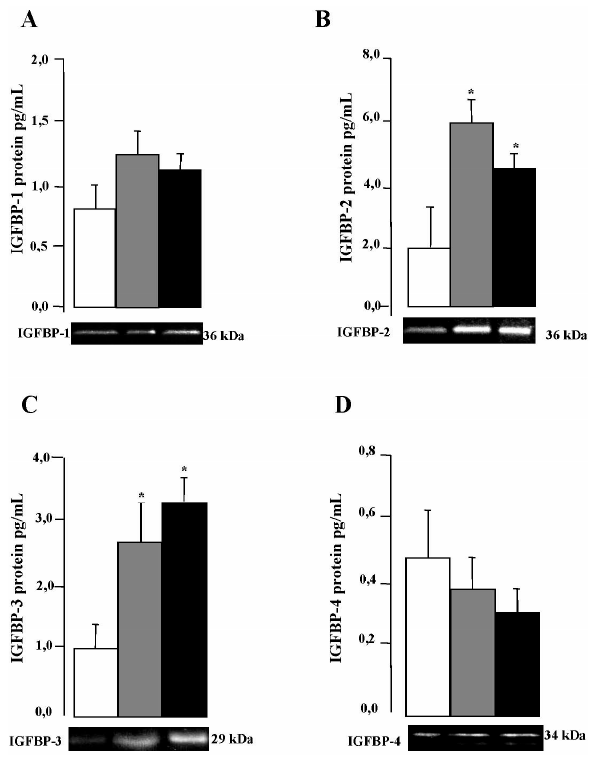
Figure 4. Significance of visceral adipose tissue IGFBP protein levels in control, LIR-MO and HIR-MO groups. xMAP assay of protein levels (columns in the “ y ” axis) and Western blotting (pictures in the “ x ” axis ) of IGFBP-1 ( A ); IGFBP-2 ( B ); IGFBP-3 ( C ); and IGFBP-4 ( D ) were done for each group. Significance of differences * p < 0.01 was compared with the control group. Columns represent the mean; bars represent SE. Table 4. Analysis of the mRNA IGFBP (1, 2, 3 and 4) expression in VAT from the control and morbidly obese groups (LIR-MO and HIR-MO).